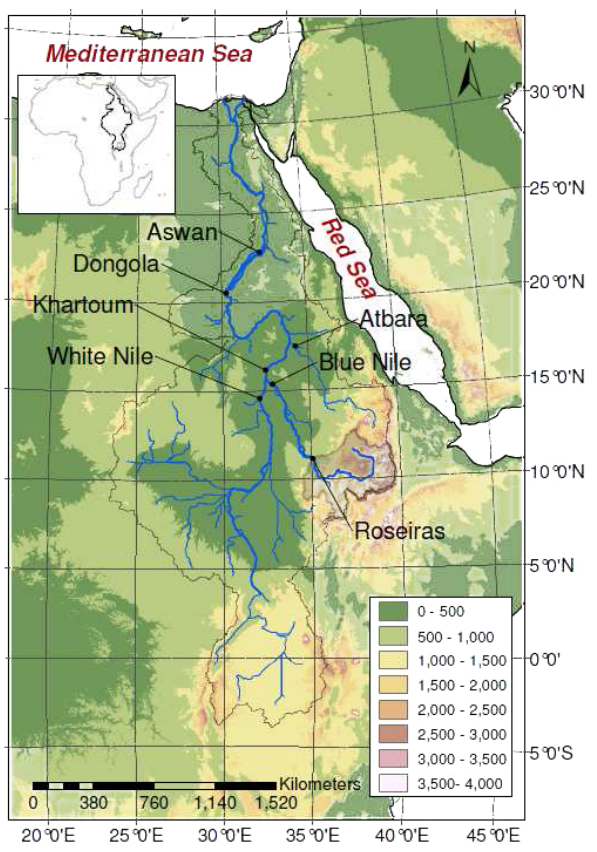
Figure 1. Topographic map of the Nile basin showing the outlet of the upper Blue Nile basin (shaded in gray) at Roseiras. The White and Blue Nile join together at Khartoum to form the main branch of the Nile that flows directly to Dongola in the north.